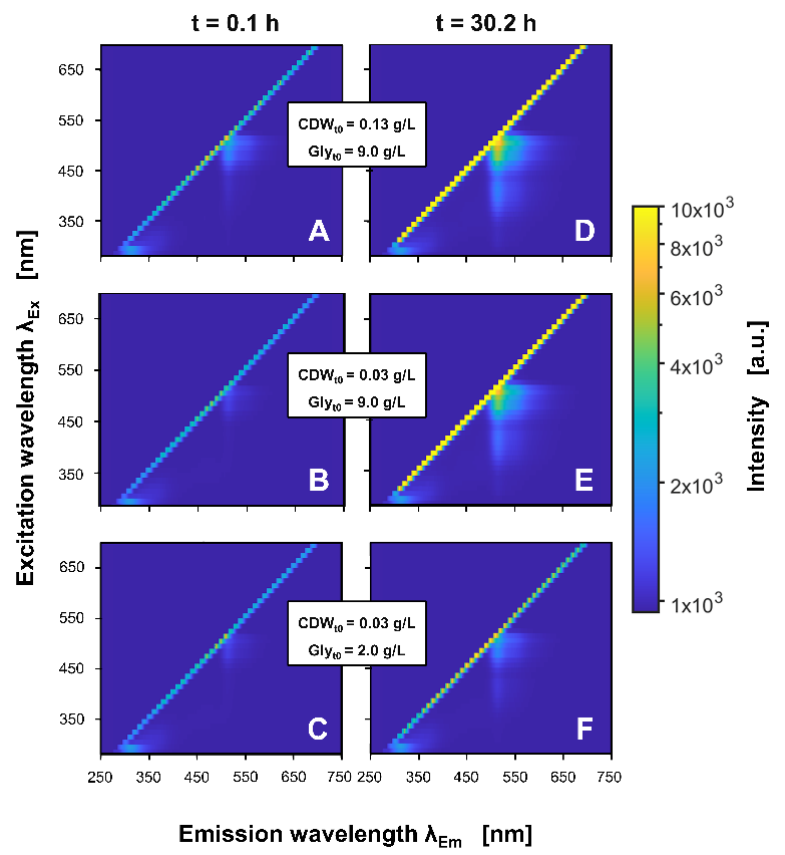
Figure 3. Exemplary 2D spectra of H. polymorpha RB11 pC9- FMD (P FMD -GFP) cultures in SYN6 medium after 0.1 h ( A – C ) and 30.2 h ( D – F ) for different initial cell dry weights (CDW t0 ) and glycerol concentrations (Gly t0 ). The spectra are recorded for cultures with 0.13 g/L CDW t0 and 9.0 g/L Gly t0 ( A , D ), 0.03 g/L CDW t0 and 9.0 g/L Gly t0 ( B , E ), and 0.13 g/L CDW t0 and 2.0 g/L Gly t0 ( C , F ). The spec- tra are smoothed according to the methods section, but not referenced to the first cycle. Spectro- scopic measurement settings: excitation wavelength range = 280 nm–700 nm (step size = 10 nm), emission wavelength range = 278 nm–720 nm (step size = 0.45 nm), integration time = 30 ms. Culti- vation conditions: 48-round-well microtiter plate, liquid volume = 800 µL, shaking diameter = 3 mm, shaking frequency = 1000 rpm, temperature = 30 °C.